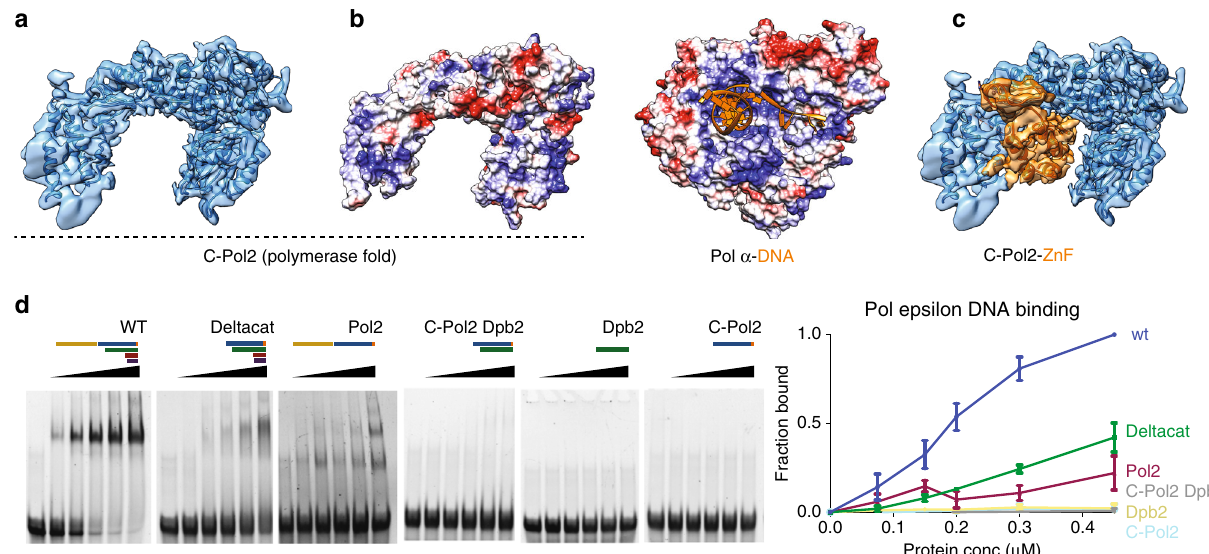
Fig. 3 The C-terminal half of Pol2 contains a catalytically dead polymerase fold that has lost its DNA-binding function. a C-Pol2 contains an inactive polymerase fold with jaws wide open. b Coulombic surface coloring of the C-Pol2 catalytically dead polymerase reveals a lack of positive charges in the vestiges of the DNA-binding groove, while the DNA-binding site in the related Pol alpha catalytic domain is positively charged. c The DNA-binding groove in C-Pol2 is occupied by the Pol2 zinc- fi nger appendix. d DNA-binding assay with various Pol epsilon variants. Only constructs containing the N-Pol2 catalytic domain or the histone-related proteins Dpb3-Dpb4 bind to DNA. We were unable to detect any DNA binding for C-Pol2 and Dpb2. On the right, quanti fi cation of the DNA-binding assays. Each experiment was repeated three times and error bars indicates standard deviation. Also refer